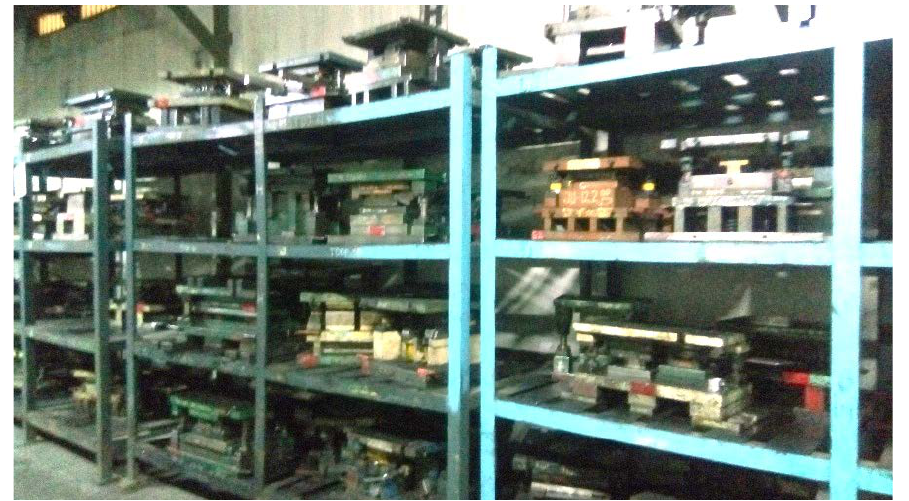
Figure 8: Storage for conventional